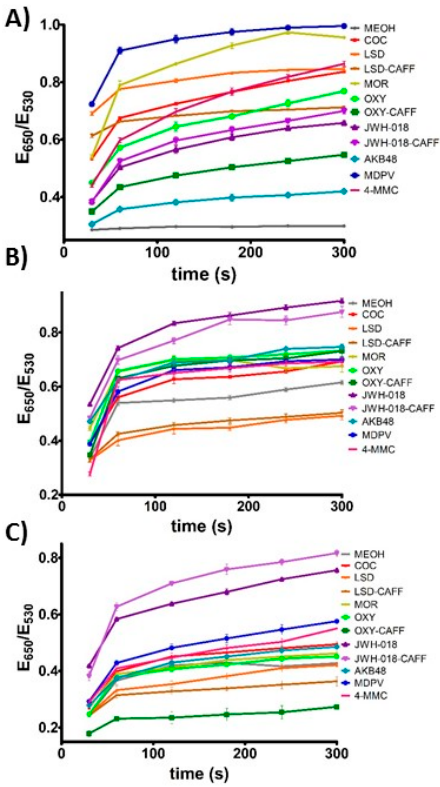
Figure 2. Controlled substance assay kinetic response. The analytes dissolved in methanol (500 µ g/mL), added to the Apt-AuNPs and after 30 s particle aggregation was promoted by addition of a final NaCl concentration of: ( A ) c-AuNPs (40 mM); ( B ) EBA-AuNPs (120 mM) and ( C ) MN4-AuNPs (80 mM).